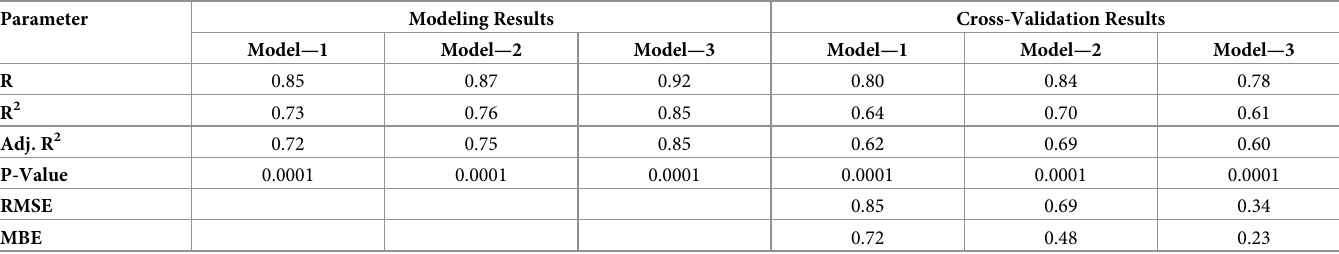
Table 6. SOC-VIs modeling and cross validation statistical results.